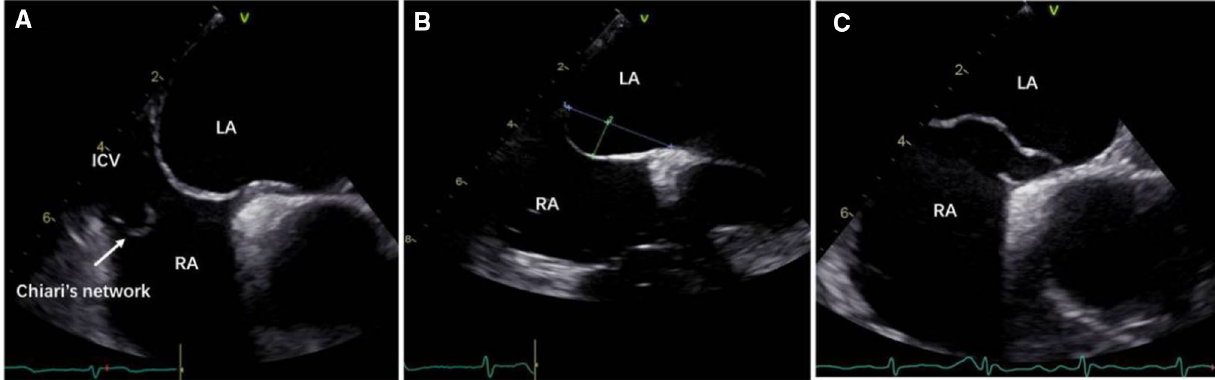
Fig. 3 PFO characteristics. A A network of threads in the right atrium with attachments to the upper wall of the right atrium were defined as Chiari’s network (arrow). B ASA was defined as ≥ 10 mm of septal